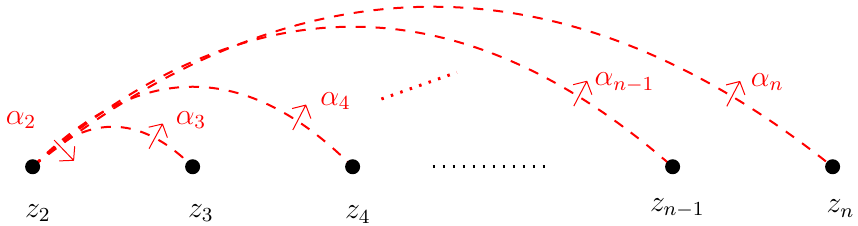
Figure 3. Choice of branch cuts for the loading T 0 ( z 1 ) with monodromies (cid:11) j = e (cid:0) 2 (cid:25)i(cid:11) 0 k 1 (cid:1) k j . Note that (cid:11) 2 = Q n (cid:11) (cid:0) 1 = e (cid:0) 2 (cid:25)i(cid:11) 0 k 1 (cid:1) k 2 is not independent of the other j j =3